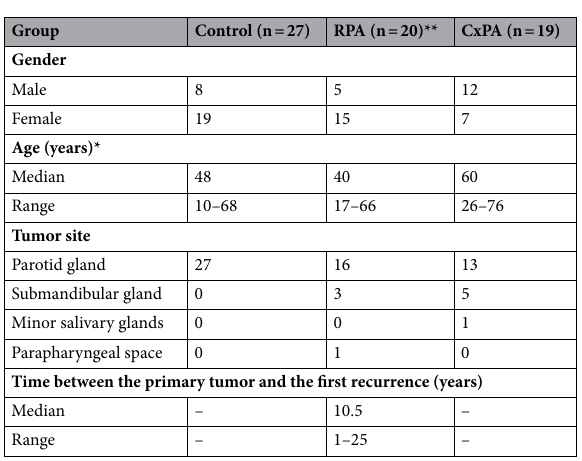
Table 2. Clinical information of patients’ groups. RPA = Patients with recurrent pleomorphic adenoma. CxPA = Patients with carcinoma ex pleomorphic adenoma. *Patients’ age at time of diagnosis. **Information available from 18/20